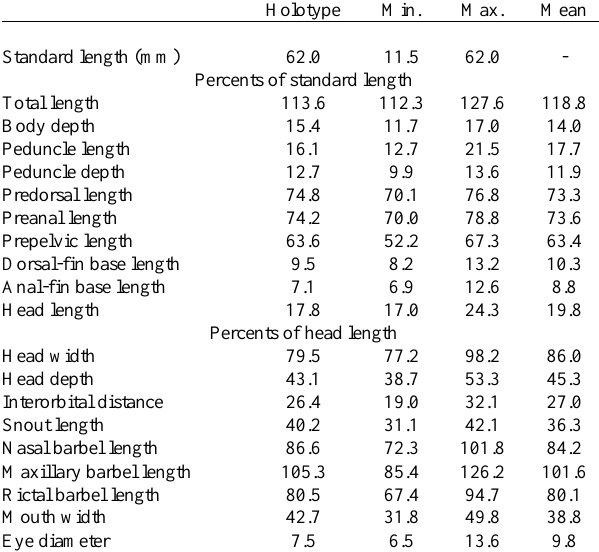
Table 1. Morphometric data for the holotype and paratypes of Ituglanis ina (n = 54 including holotype).